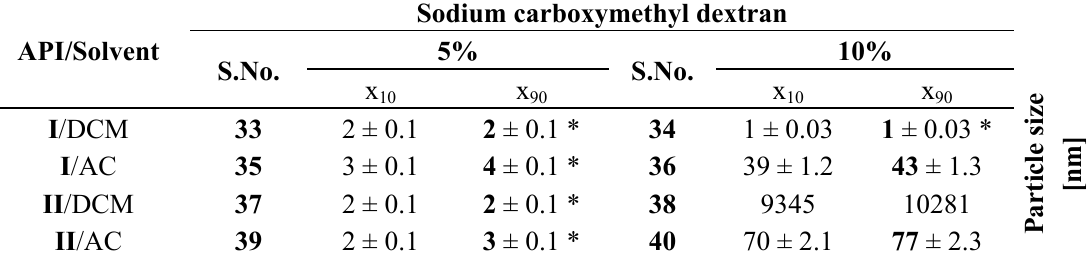
Table 5. Particle size (x , x [nm]) of APIs I , II and concentration [%] of sodium 10 90 carboxymethyl dextran in dichloromethane (DCM) or acetone (AC). All the presented results are reported as the medium value of four independent measurements. The results of nano-size samples are expressed as the mean ± SD ( n = 4 measurements). The SDs of micro-size samples are not indicated due to the measurability range of Nanophox. Samples that contained nanoparticles <200 nm are bolded; nanoparticles <10 nm are indicated by asterisk. (S.No. = sample number).